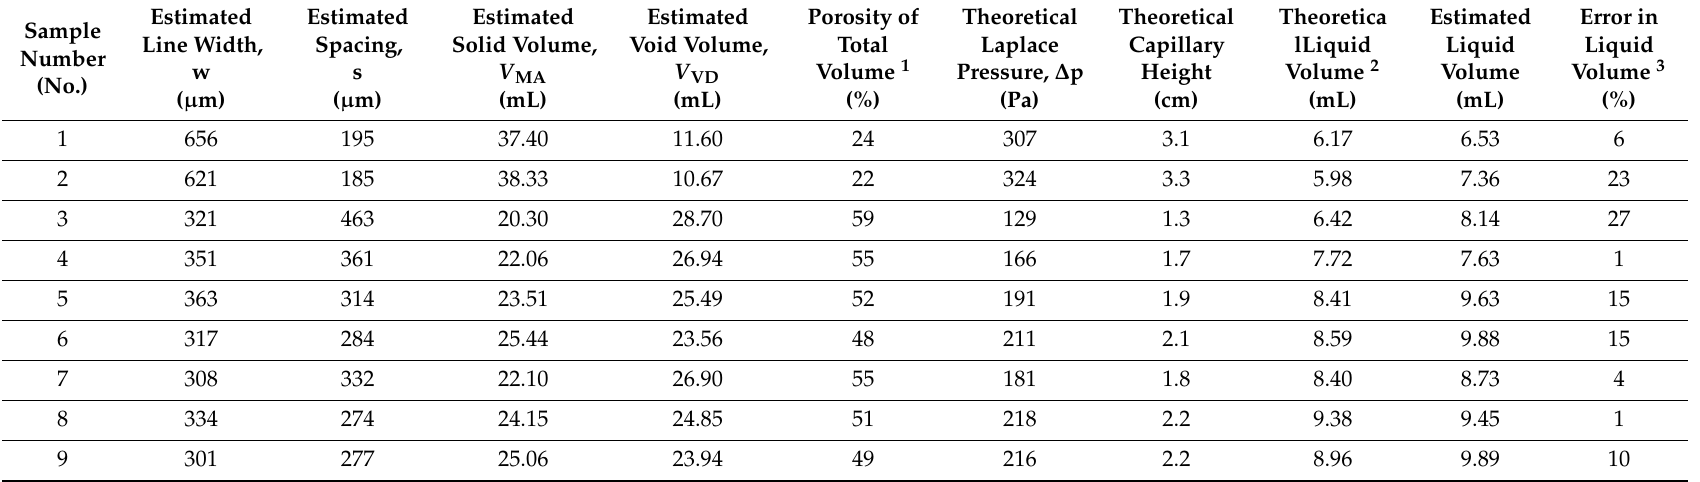
Table 1. Measurement and comparison of capillary equilibrium for the nine samples of porous network structures fabricated by the 3D printing method of PLA in the